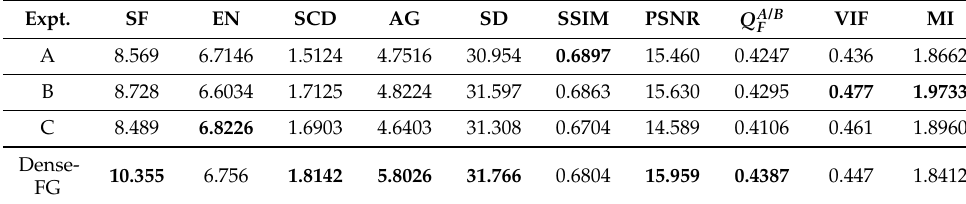
Table 4. Mean values of image metrics for different fusion algorithms .